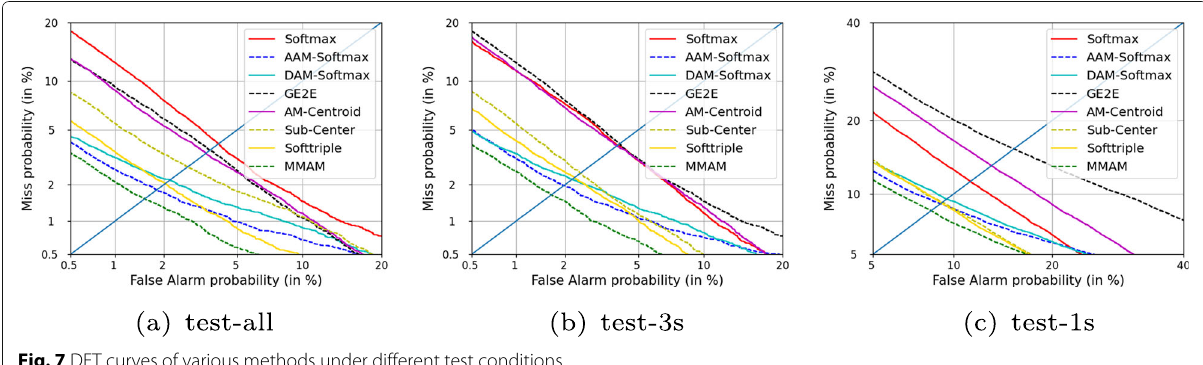
Fig. 7 DET curves of various methods under different test conditions